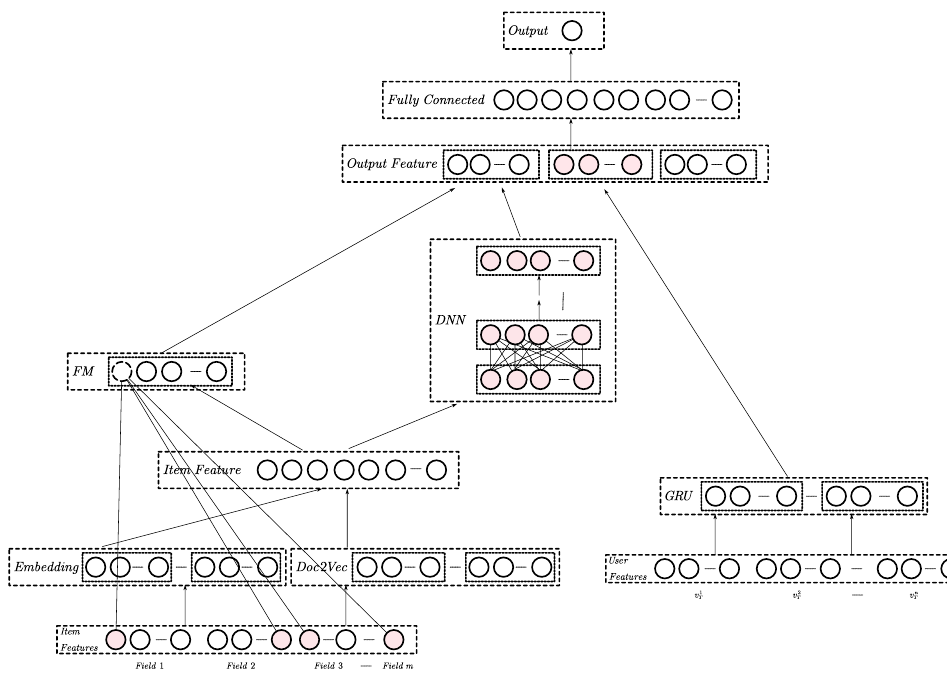
Figure 1. Algorithm structure